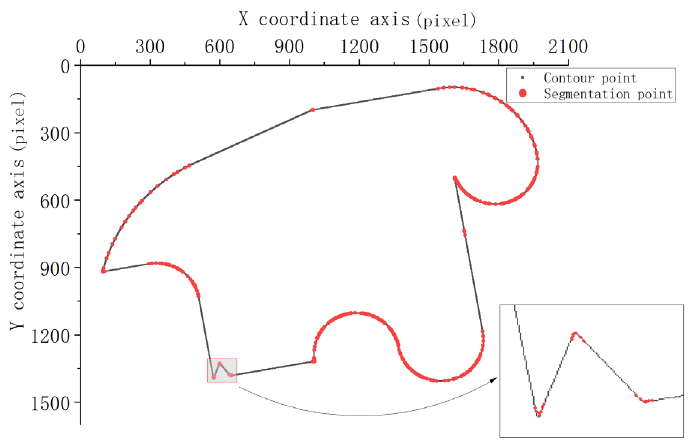
Figure 9. Segmentation points from initial screening.